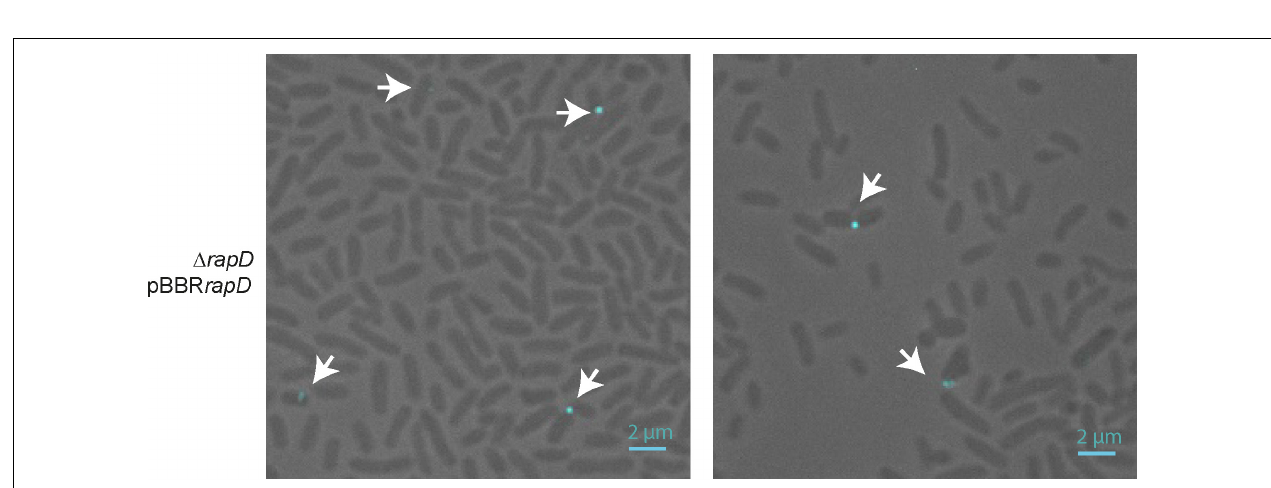
FIGURE 3 | RapD colony blot. (A) The macroscopical aspect of the macrocolonies of several Rlv 3841 derivative strains grown in TY and Y-minimal media at 28 ◦ C and Immuno-detection of secreted RapD retained on the nitrocellulose membrane placed on semisolid medium using specific anti-RapD antiserum. (B) Western blot analysis of extracellular proteins secreted by Rlv 3841 derivative strains after 72 h analyzed by 15% SDS-PAGE. Immunodetection of secreted RapD was revealed by an anti-mouse secondary antibody HRP-conjugated.